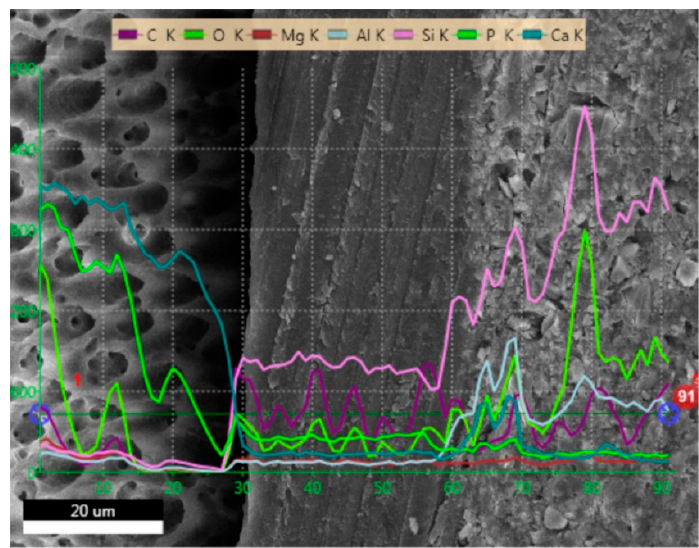
Figure 5. EDS line scan signals of individual elements present at dentin-resin interface obtained for Adper Easy One applied in two layers.